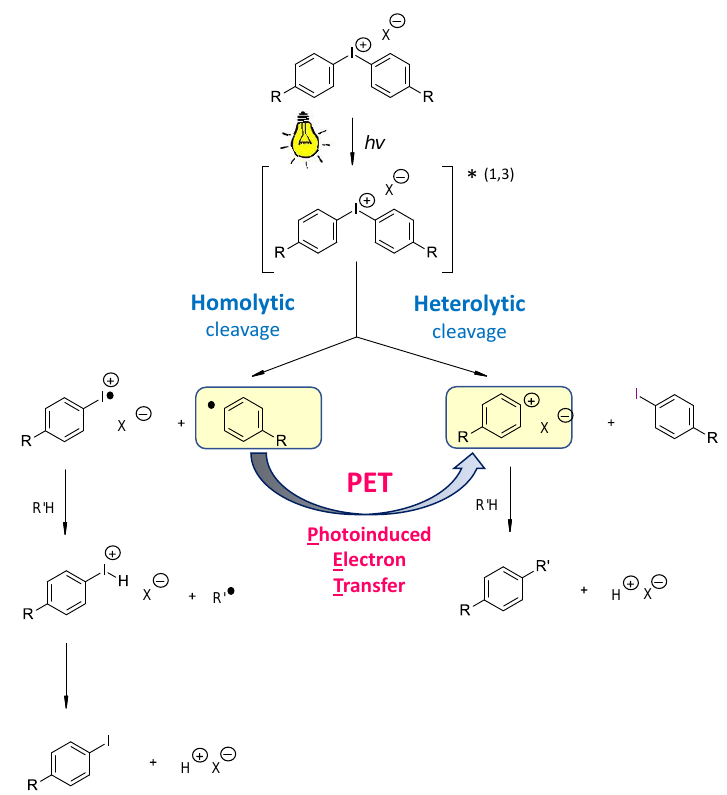
Scheme 3. Photolysis of diphenyliodonium salt as a typical example of onium salt.